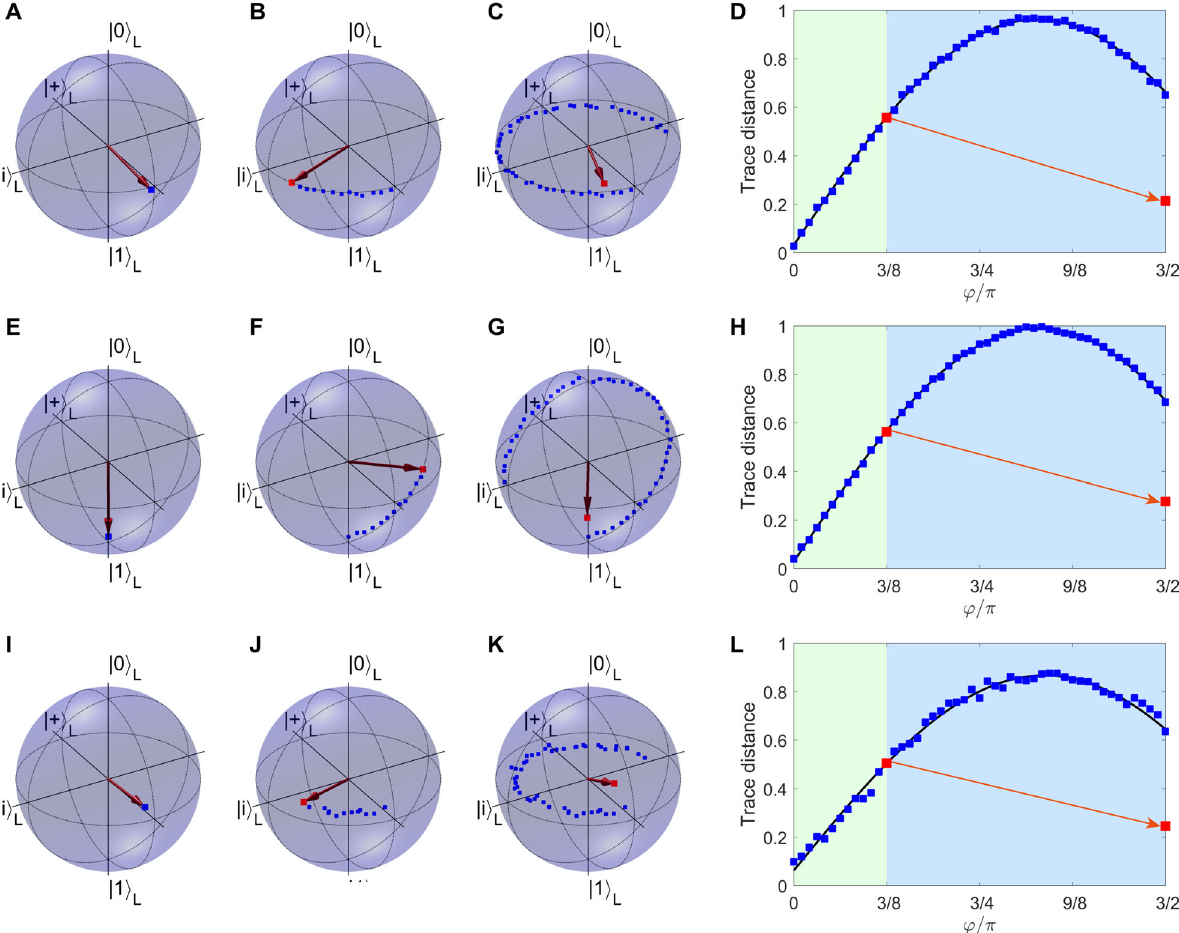
Fig. 2 Resetting the target qubit after a free evolution. On the Bloch spheres, the evolution of the states for the three phases are presented: After state preparation ( a , e , i ), after free evolution ( b , f , j ), and after resetting ( c , g , k ). The resetting protocol is applied when the free-evolution induced phase is φ = 3 π /8. The red dots mark the state before and after a successful reset. The blue dots mark a free evolution without resetting as a comparison, simulating the results of the time-independent Hamiltonian H 0 . As the resetting protocol requires three more free evolutions, the state without the resetting process is measured till φ = 3 π /2. From top to bottom, each row shows a different version of the resetting protocol in case 1, demonstrated the resetting process for a superposition state (cid:2)j i , a classical state 1 j i , and a mixed state, respectively. In ( d , h , l ), the trace distance after the application of resetting protocol are observed jumping from 0.557, 0.564, and 0.506, to 0.214, 0.277, and 0.246, respectively.